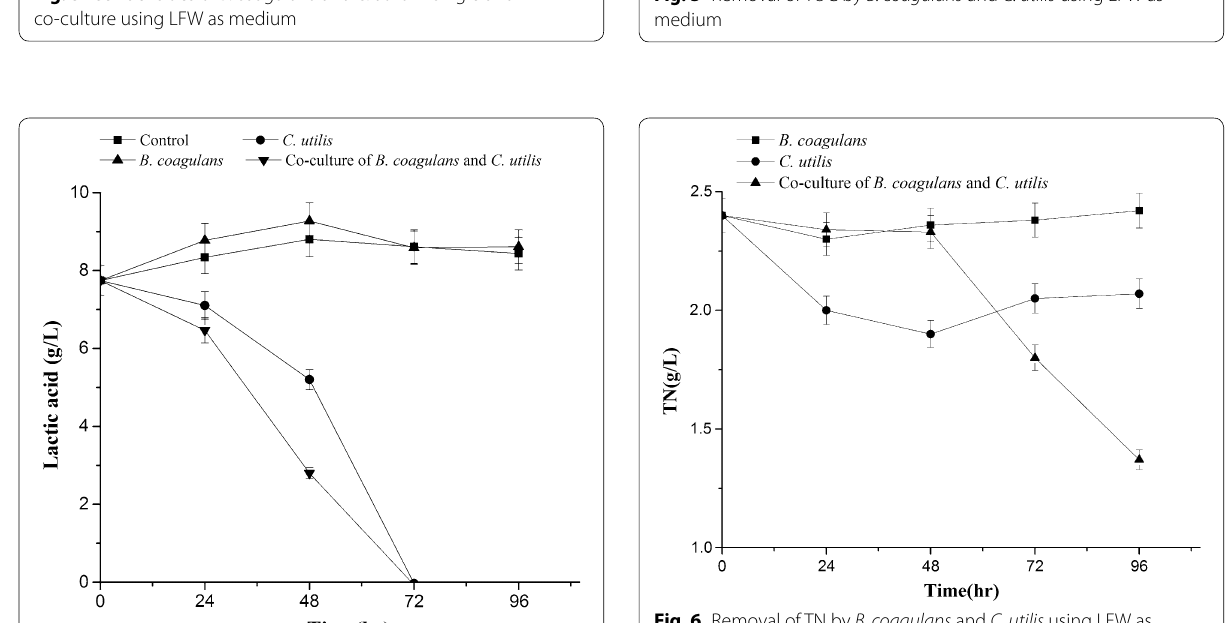
Fig. 3 Cell densities of B. coagulans and C. utilis in single and